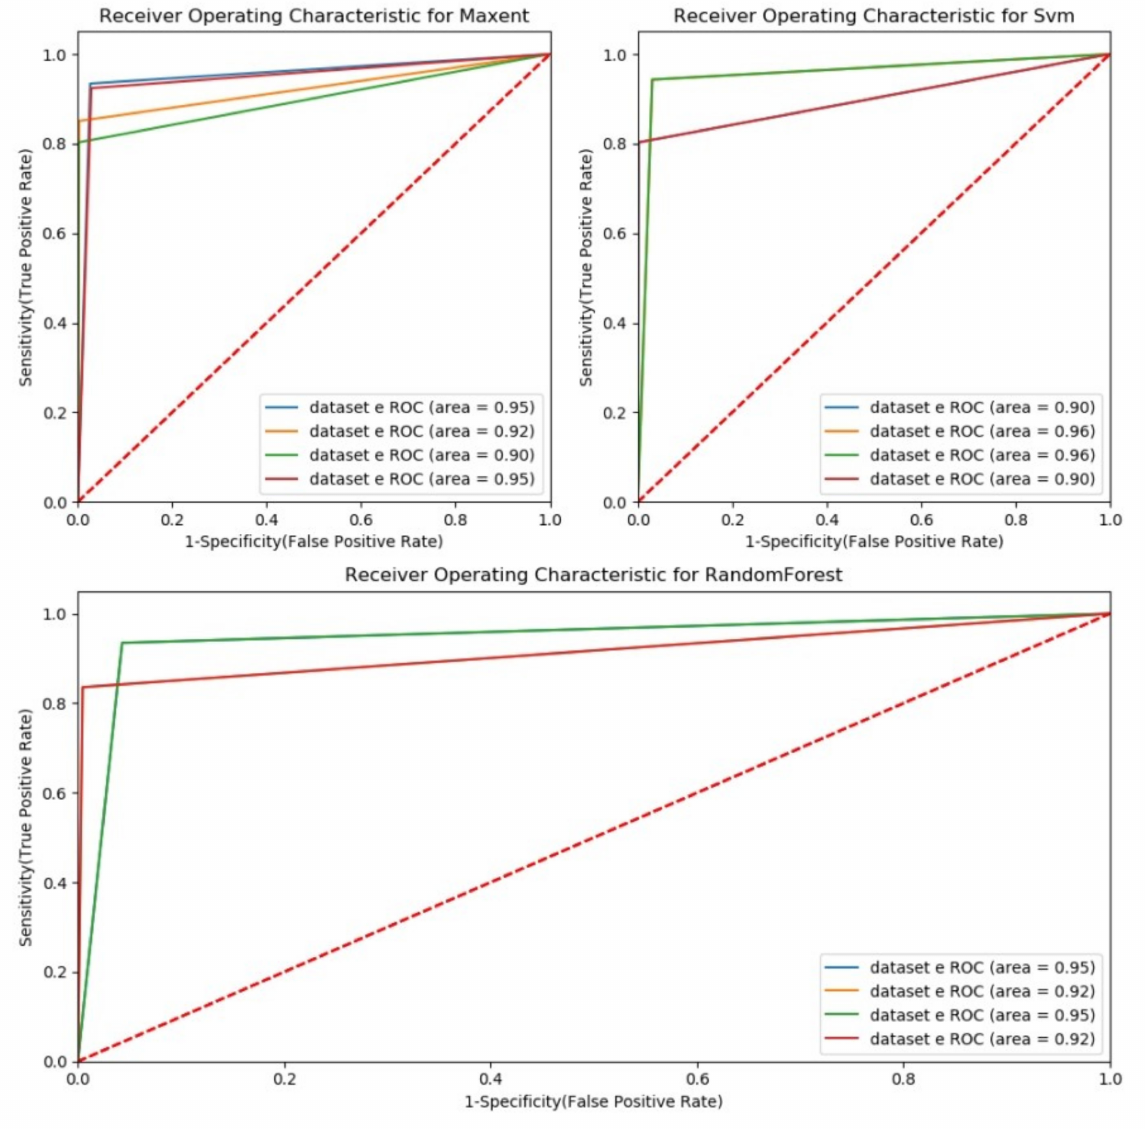
Figure 8. Roc curve for comparative study for SVM, MaxEntropy and Random Forest algorithms foreach dataset as the first module for filtering the